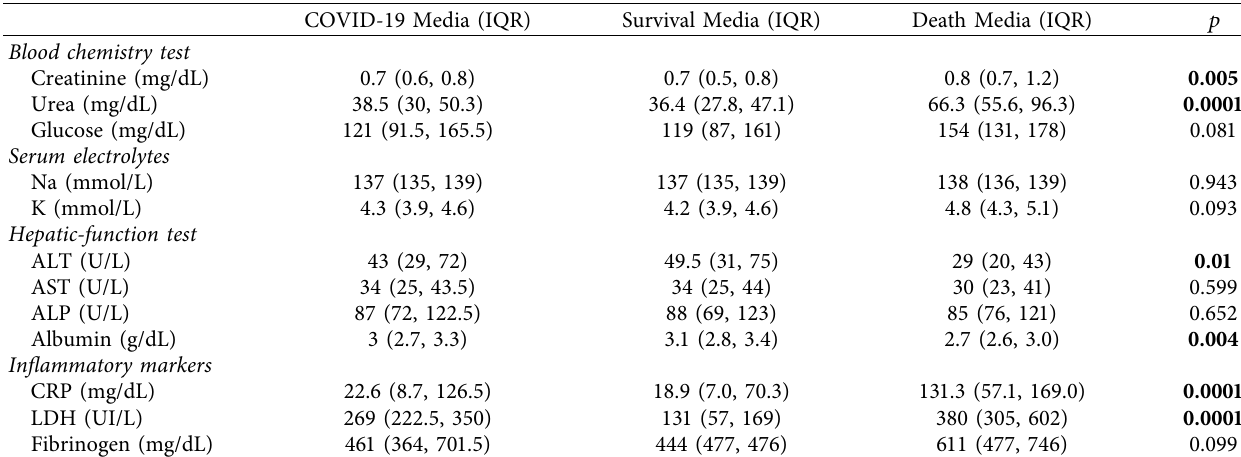
Figure 1: ATR-FTIR spectra of saliva samples of hospitalized patients with severe COVID-19 who survived or died. (a) Mean of the ATR- FTIR spectra of both groups, including the biological fngerprint region at 1800–800cm − 1 . (b) Biochemical components assignation to the peaks. p represents the statistical signifcance after the Mann–Whitney U analysis. Table 4: Biochemical parameters on hospitalized patients with severe